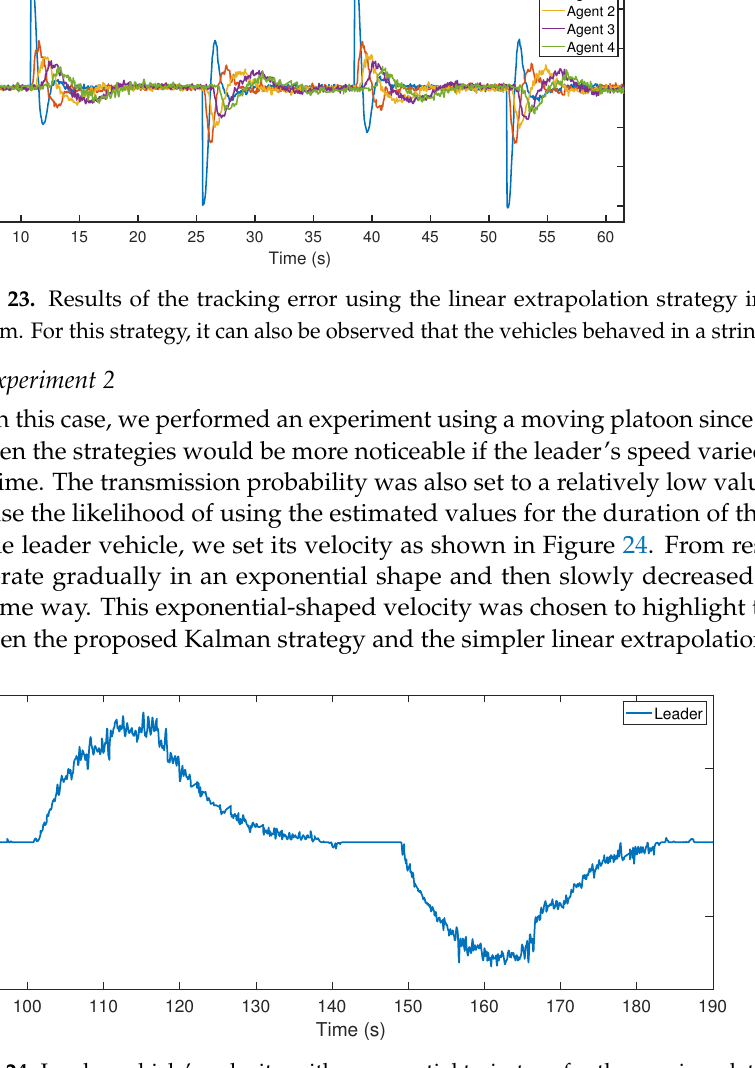
Figure 24. Leader vehicle’s velocity with exponential trajectory for the moving platoon experiment.